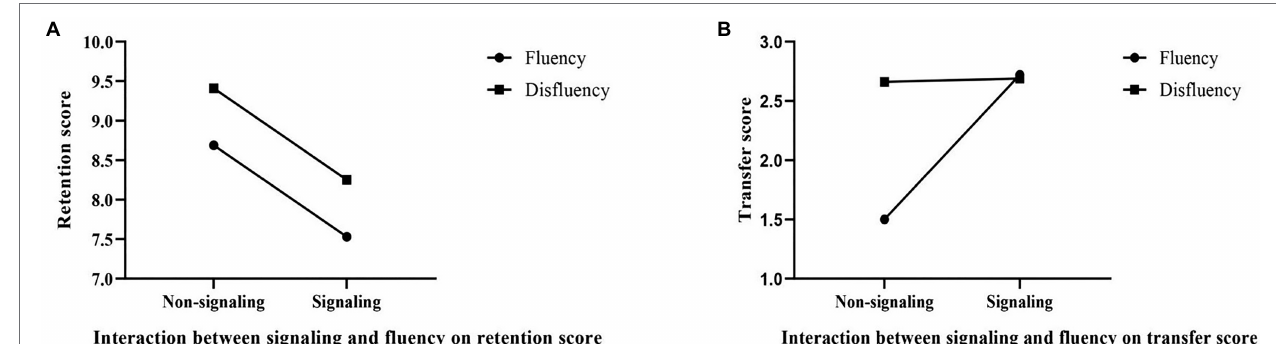
FIGURE 2 | (A,B) Interaction between signaling and fluency on retention and transfer